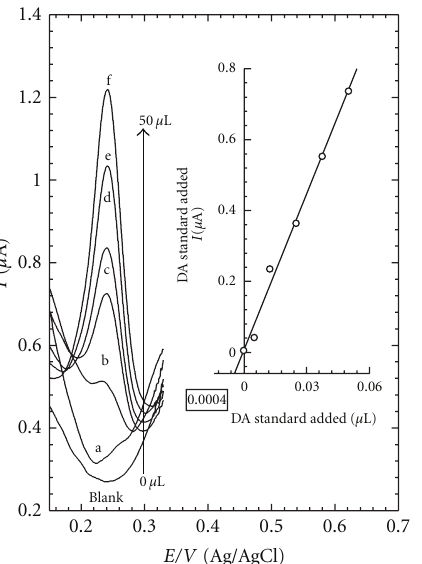
Figure 8: Di ff erential pulse voltammograms obtained on GC/RuOHCF/RuHCF electrode. Solutions prepared by standard addition into the blood plasma as follows: (a) 0.00, (b) 5.0, (c) 12.5, (d) 25.0, (e) 37.5, and (f) 50.0 μ L of 2mMDA solution. Inset shows calibration curve obtained from variations of the stripping peak current as a function of DA concentration (see the text for